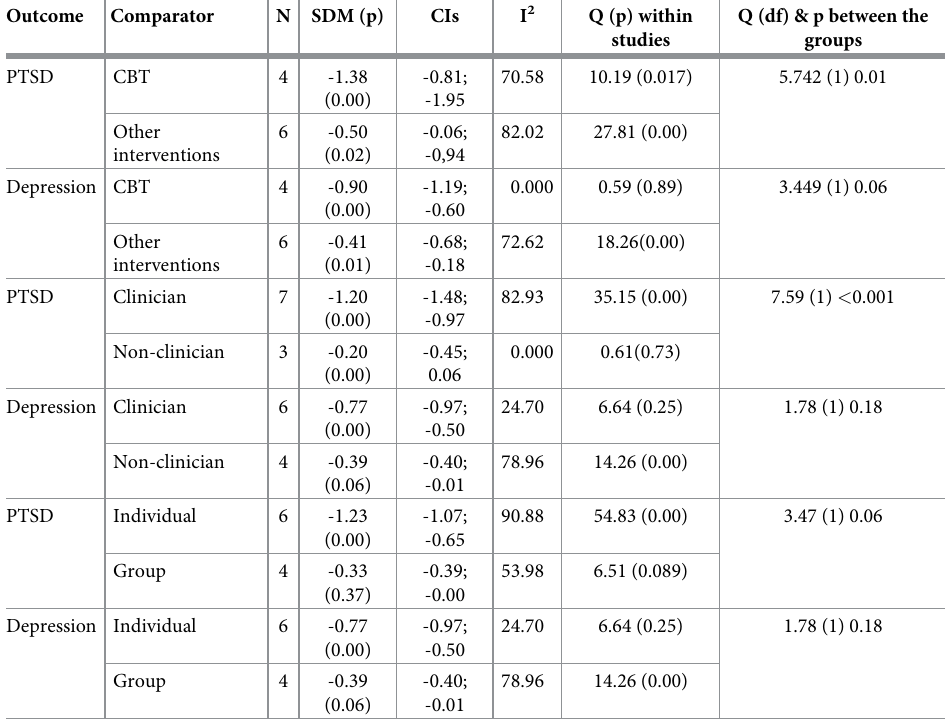
Table 2. Comparing between three categories of interventions: CBT versus other interventions; clinician versus non-clinician providers; and individual versus group interventions for PTSD and depression.